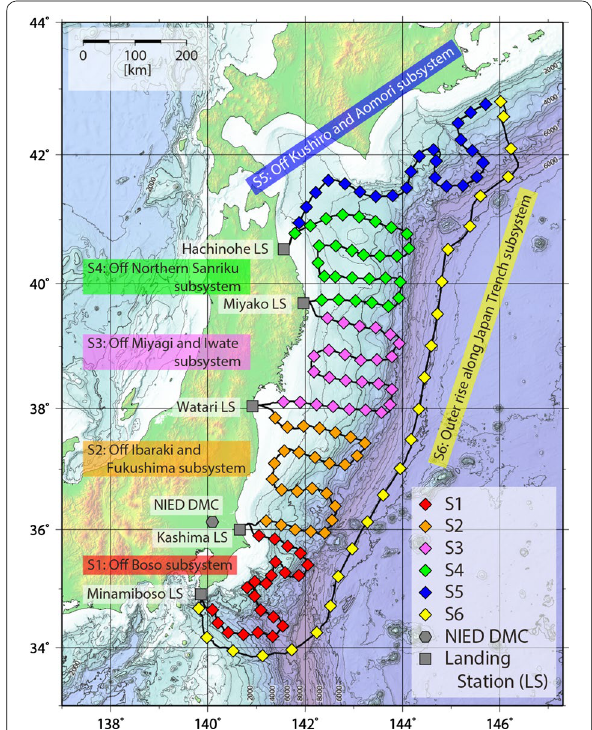
Fig. 4 Distribution of S-net observatories with landing stations. The contours indicate